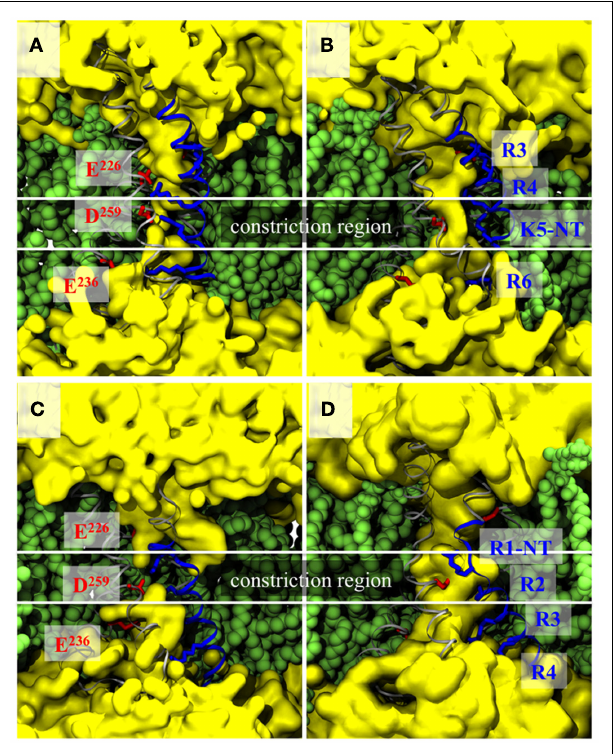
FIGURE 3 |VSD topologies of the activated (A,B) and resting (C,D) states of the Kv1.2VSDs before mutation, i.e., in the wild-type channel (A,C) and after mutation of a single residue, i.e., K5 in the activated (B) and R1 in the resting (D) state. Representations and colors are the same as in Figure 2 .The water is represented as a continuous surface (yellow) and highlights the presence of a constriction in theWTVSDs and not in the